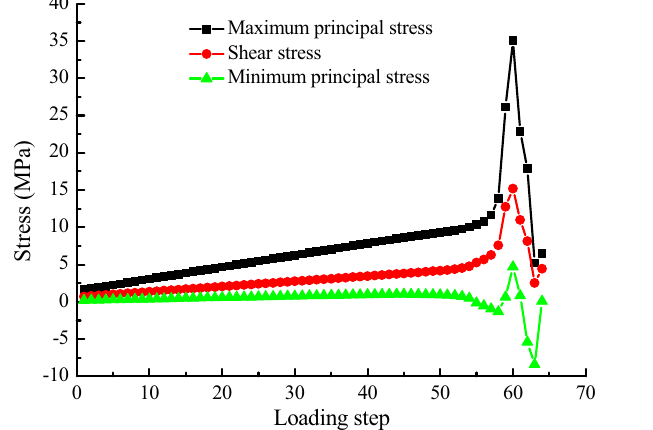
Figure 6. Various stress curve of point P in landslide process.